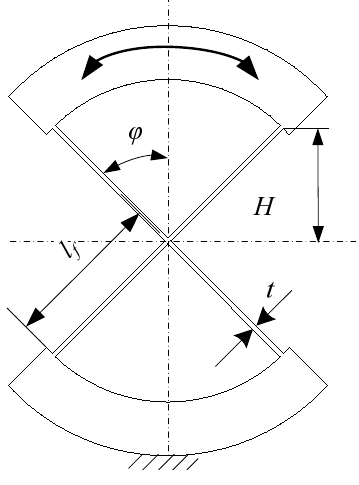
Figure 3. Parametric model of the cartwheel hinge.